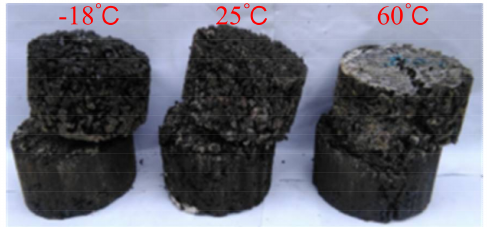
Figure 10. Appearance of PPM-10 + AC-20 composite specimen after shear